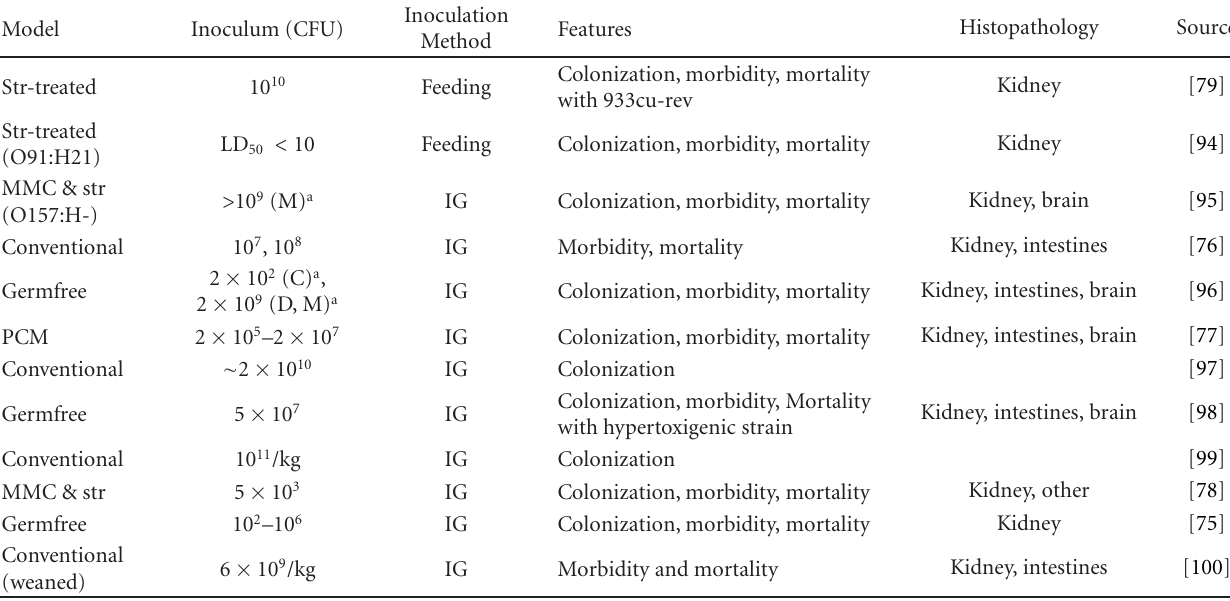
Table 1: Commonly used mouse models of STEC colonization and/or